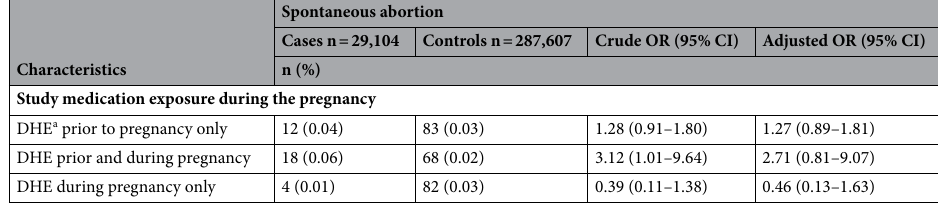
Table 10. Association between DHE exposure before or during pregnancy and the risk of spontaneous abortion by categories of DHE exposure. Adjusted for all variables included in Table 6. a Dihydroergotamine.